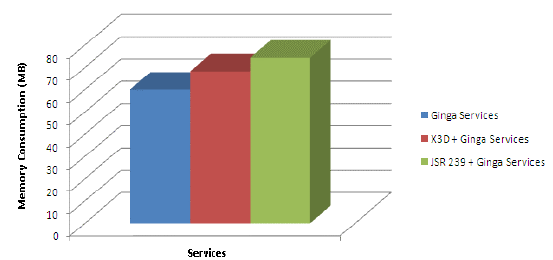
Figure 12. Memory consumption for Ginga specific